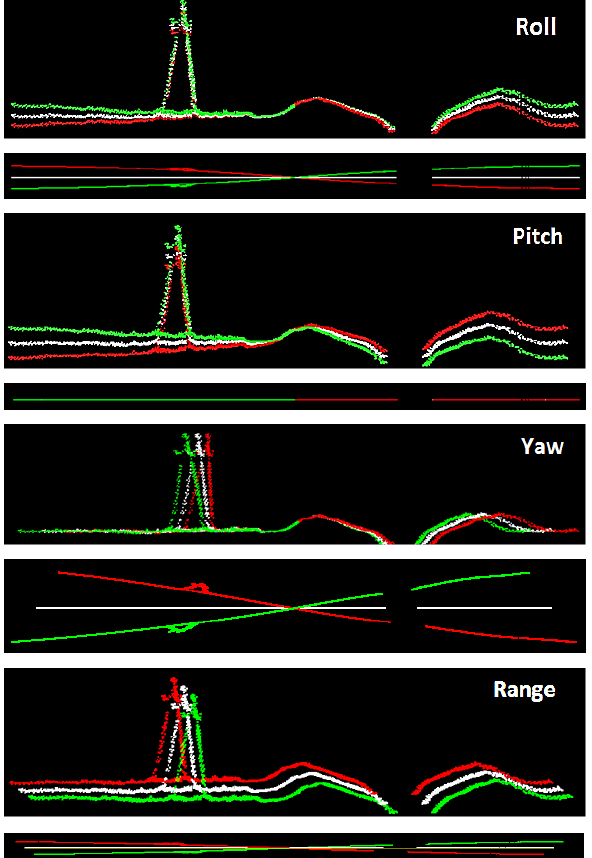
Figure 4. Influence of roll, pitch, yaw and range errors on the point positions (white—reference point cloud, red—negative error value, green—positive error value) In order to show how the factors influence a point cloud, a transverse cross section is used. This part of the point cloud presents an area near a river. The cross section contains an electricity pole and levees. Every factor is analysed separately in order to understand their impacts better. Additionally, the cross section is presented in two views: a top view and a front view. On every figure three cross sections are shown. The white point cloud is the reference one, green point represent a positive error value and red ones represent a negative error value. To show the impact of these errors, their sizes have been magnified for roll, pitch, yaw and range (dRoll=dPitch=2 degrees, dYaw=5 degrees, dRo=1 Figure 3. Accumulated graphs for yaw, pitch, roll, range and theta influence on horizontal and vertical position for 3 incidence angle values: 0, 30 and 60 degrees (H=40 m, GNSS errors are excluded)